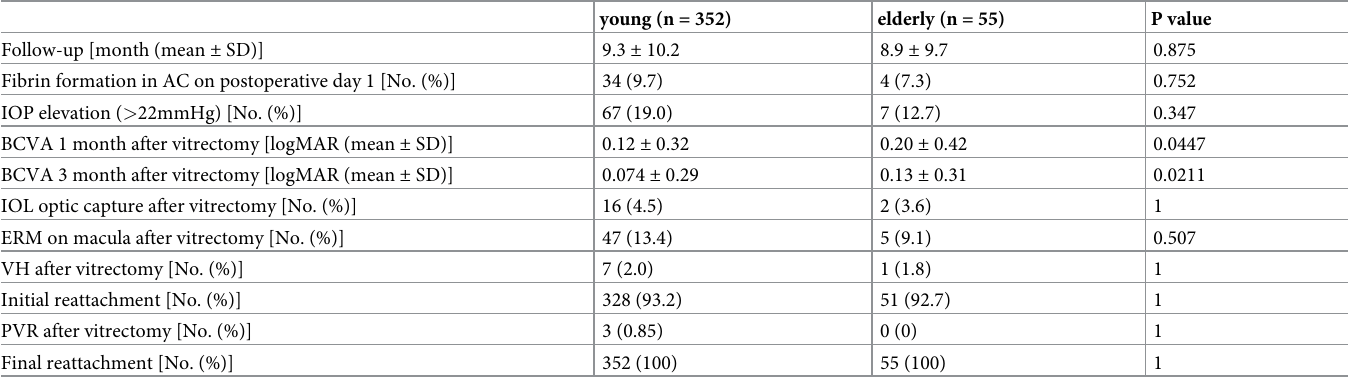
Table 4. Postoperative outcome measures in elderly and younger